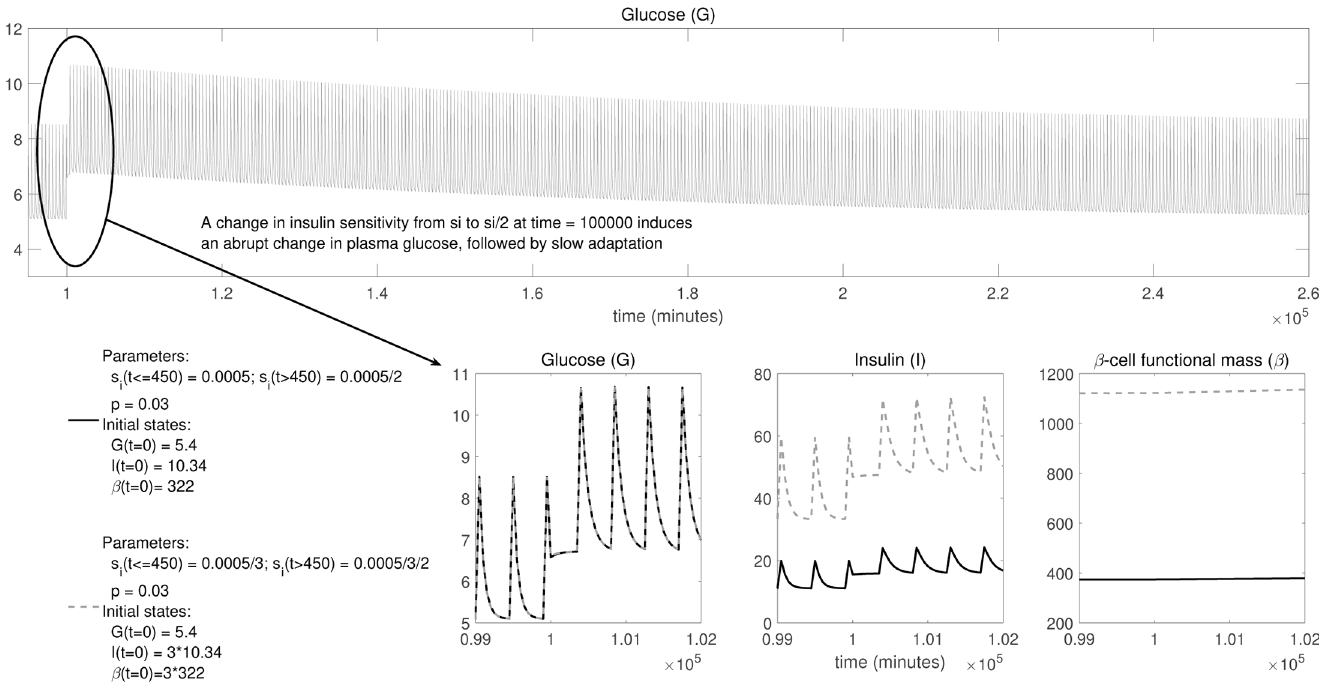
Fig 4. Unidentifiability of s i from measurements of glucose off steady state. The upper plot shows the time-course of plasma glucoseconcentration in the β IG model in a regimeof periodicinputs (pulses) of externalglucose from meals, similarlyas in Figs 2 and 3. At time 100000there is a sudden changein the insulinsensitivity parameter, s i , which is halved as a result of external perturbations. This produces an abrupt change in the glucoselevel, which then undergoesa long periodof adaptation until its baselinereturns to the originallevel. The lower plots show in more detail the behaviour of glucoseand the other two state variables, insulinand β -cellmass, in the hours immediately before and after the changein s i . These plots illustrate that it is not possibleto infer the value of the s i parameter in the β IG model by measuring only glucose,even if measurements off steady state are availableand p is known. This is indicatedby the fact that the dynamic time-course of glucoseconcentration (G) is identicalfor s long as the initial conditionsof the two unmeasured states, insulin(middleplot) and β -cell mass (right plot), are multiplied by the same factor k . The figure ¼ 0 : 0005 ; p ¼ 0 : 03 g shows results for k = 3 and f s (cid:3) i